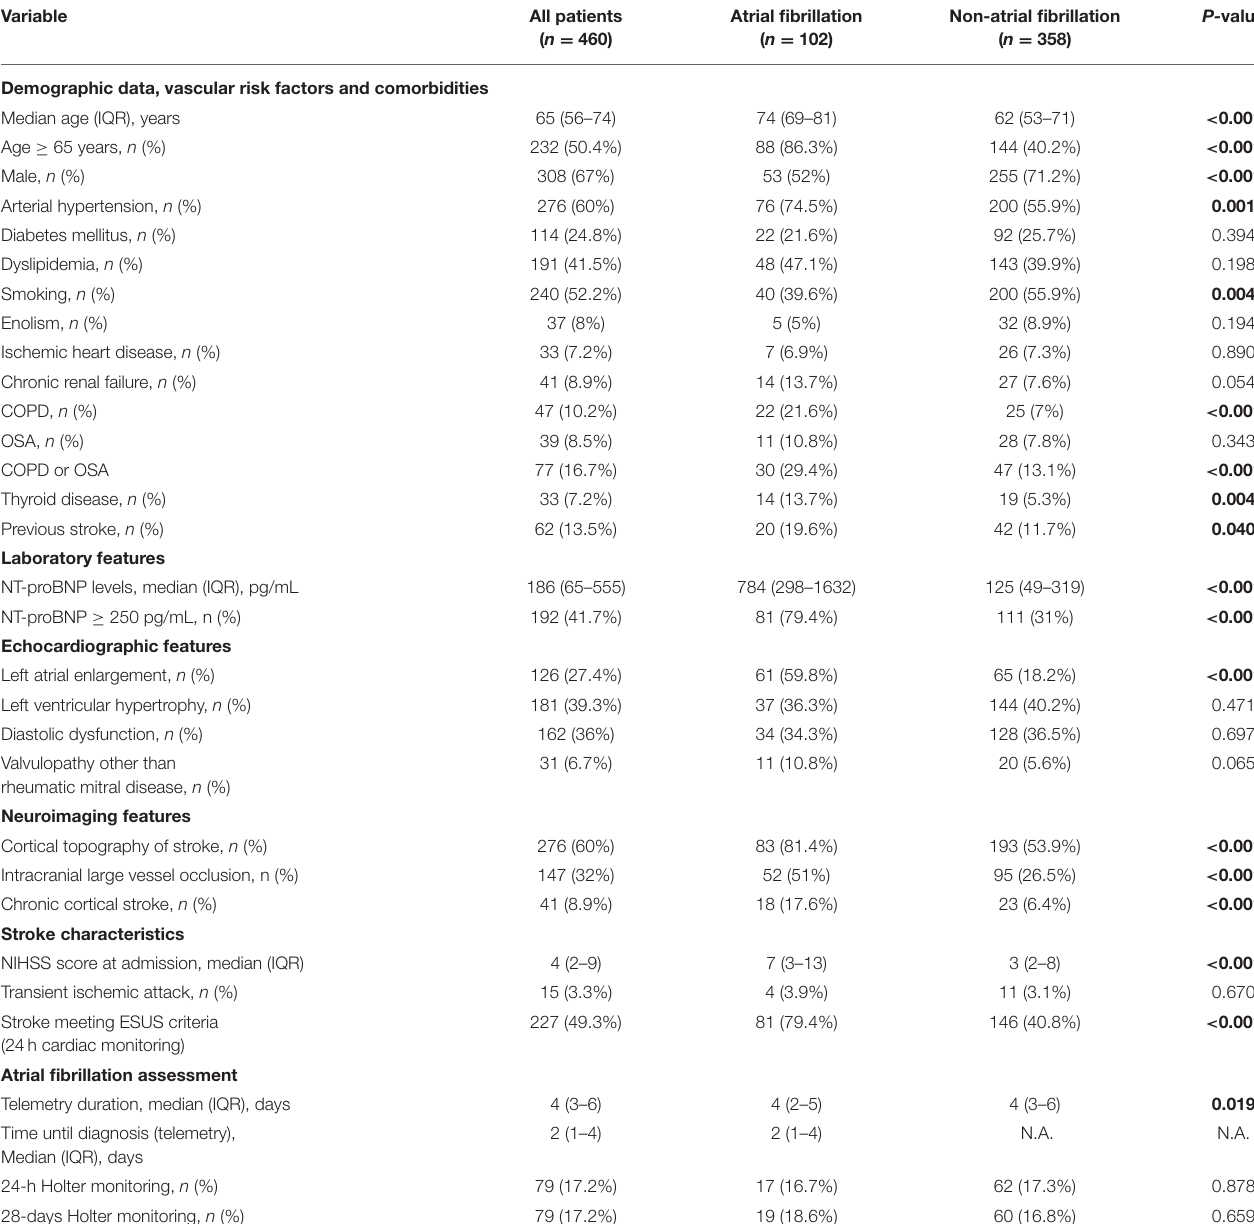
TABLE 1 | Baseline characteristics and univariate analysis.